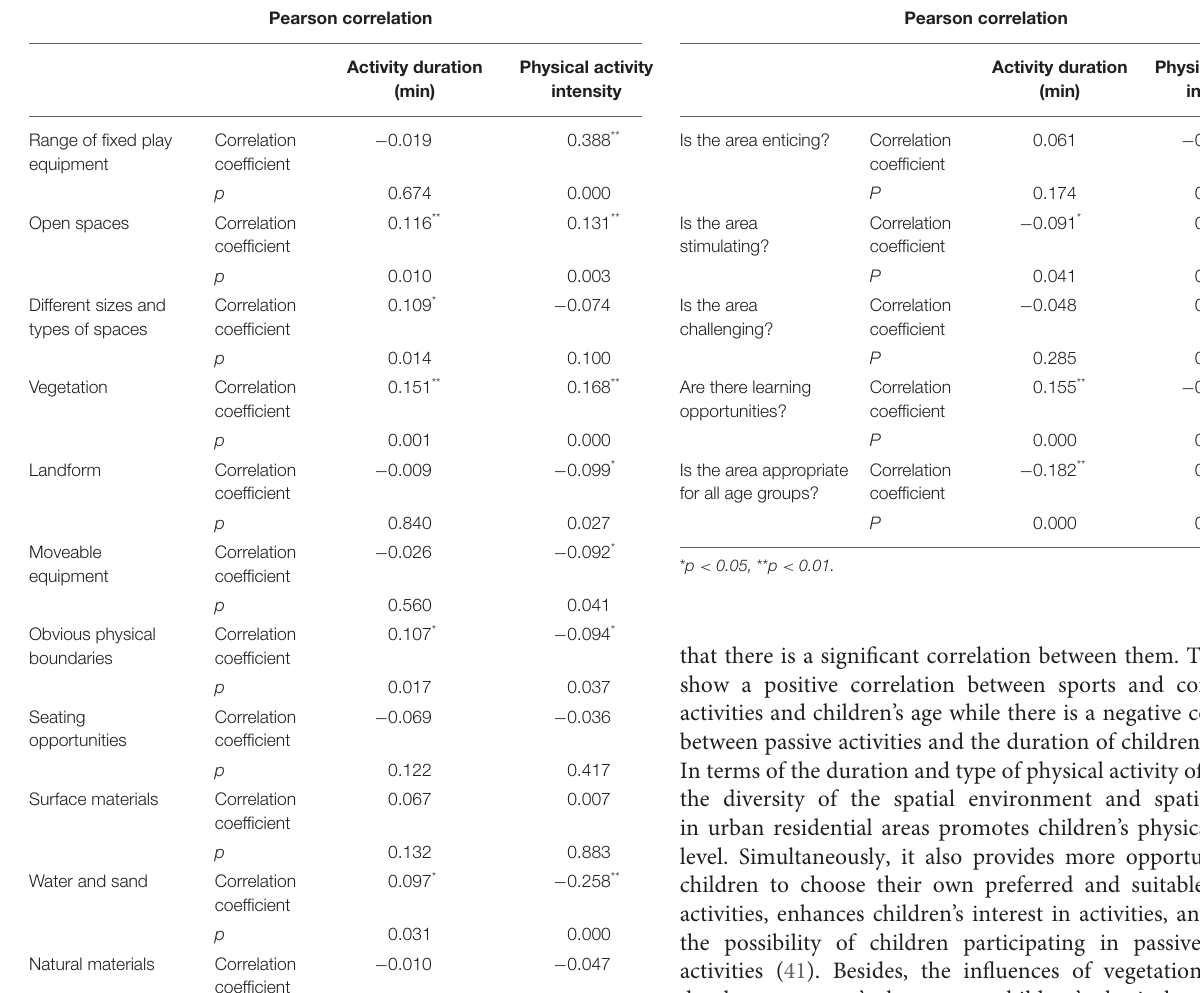
TABLE 4 | Correlation analysis of the duration and intensity of children’s physical activity and neighborhood spatial factors.